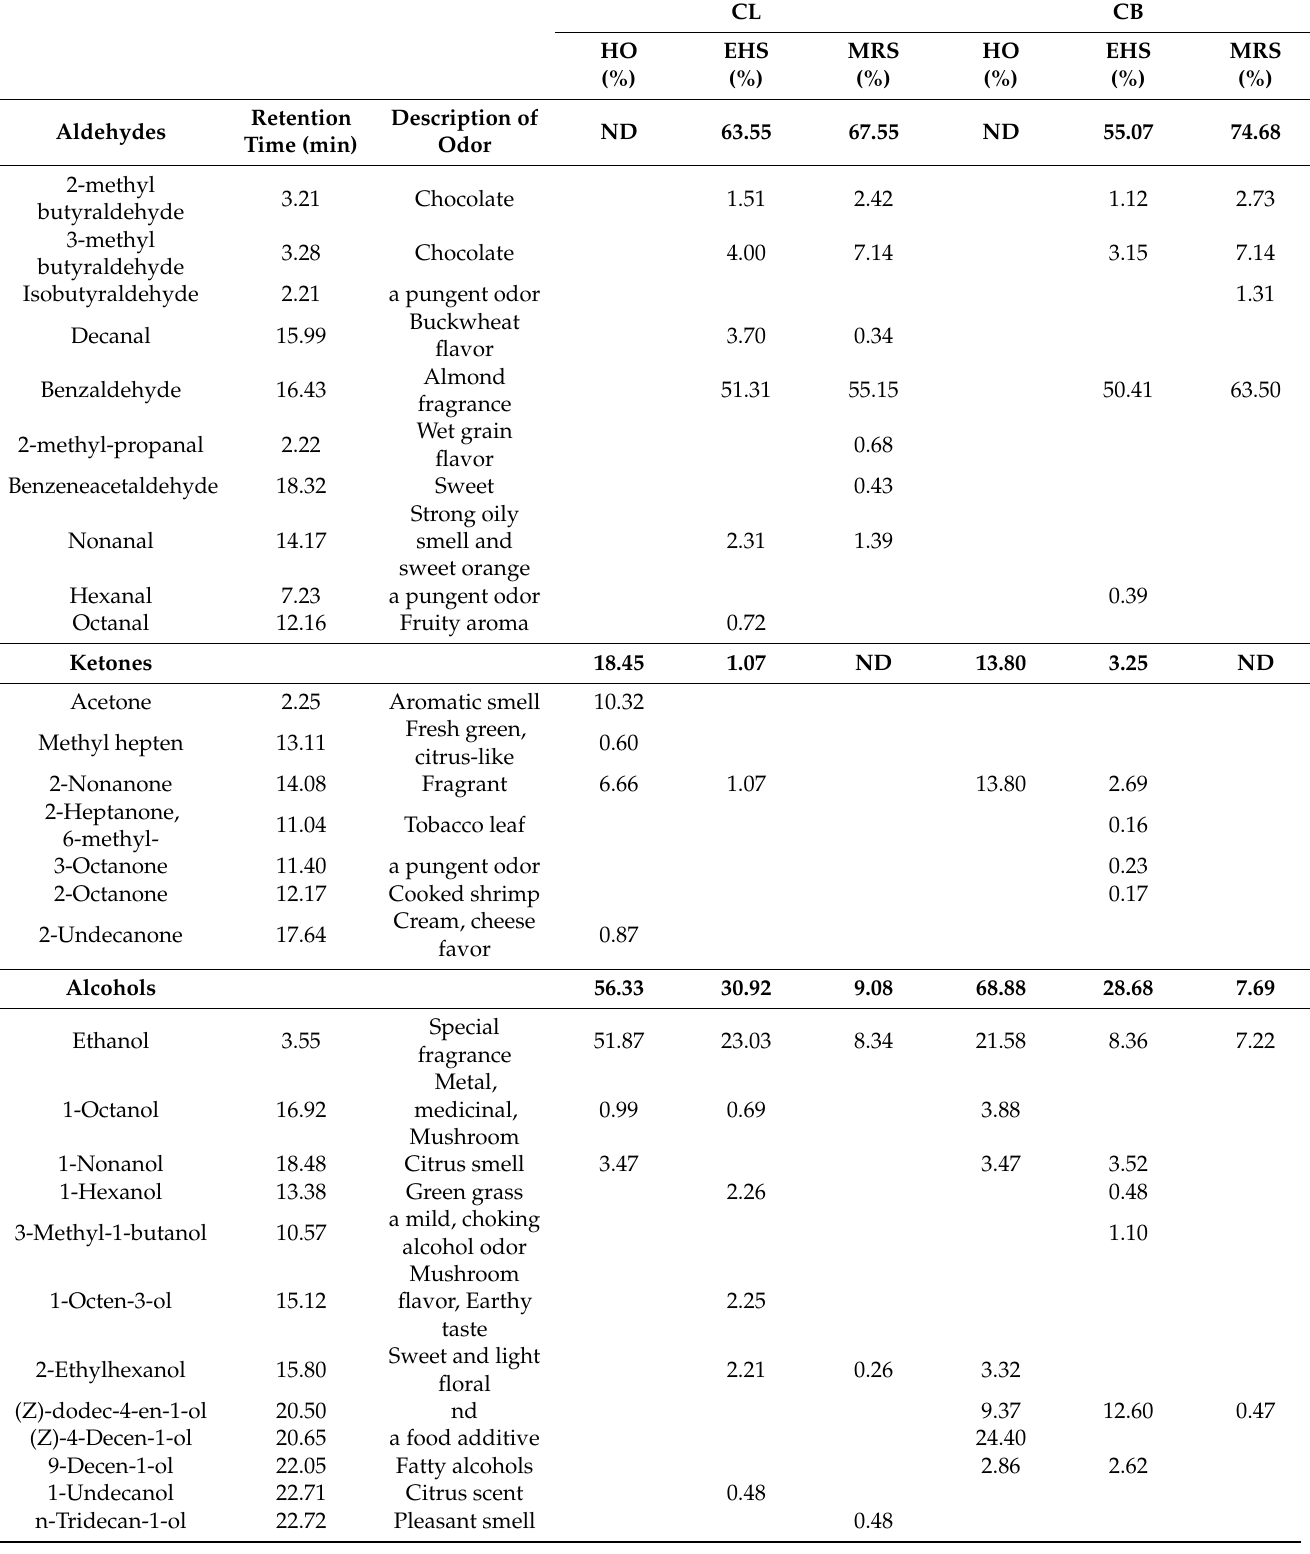
Table 3. Composition of volatile compounds detected in the HO, EHS, and MRS of CLs and CBs from Eriocheir Sinensis